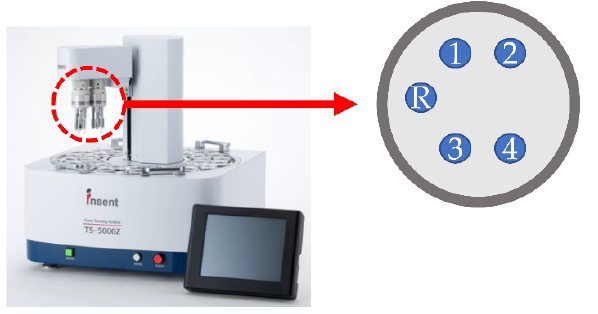
Figure 3. Taste sensor system TS-5000Z. One measurement cell could contain at most 4 sensor electrodes and 1 reference electrode. The 4 sensor electrodes do not need to use exactly the same membrane. In this study, the membranes used in the 4 sensor electrodes of one measurement cell were the same in measuring the samples and calculating the standard deviations.